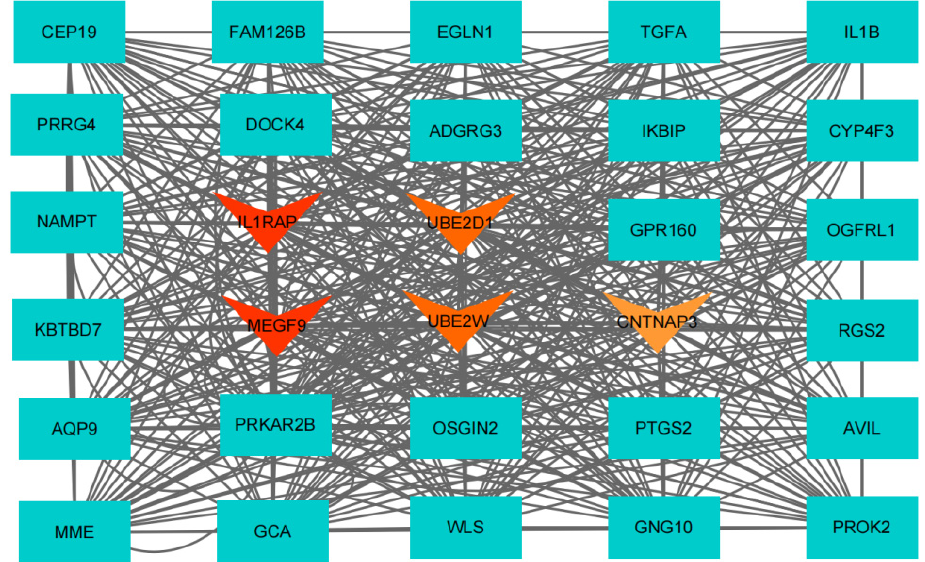
Figure 4. Networks of hub genes in the blue module. Triangular nodes represent hub genes; downward nodes represent downregulated genes, with darker red representing higher scores.